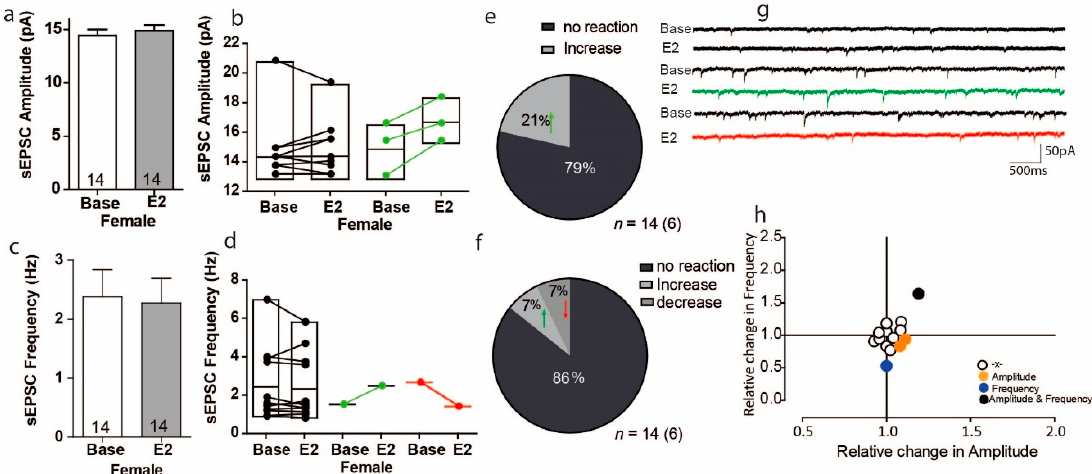
Figure 1. Estradiol causes a reaction in a subpopulation of cells in the PFC of female mice. ( a ) Average amplitude of sEPSC recordings in mPFC during baseline and after E2 treatment. ( b ) Plots showing individual sEPSC amplitude responses to E2 during the baseline and after E2 treatment in the same cell. 3 of 14 cells in the within-cell analyses showed significant increases after E2 treatment. Unless noted, colored symbols represent the subset of cells in which within-cell statistical analyses showed significant effect of E2. Green connected symbol represents cells that had a significant increase in response to E2. ( c ) The overall response to E2 on sEPSC frequency in mPFC during baseline and after E2 treatment. ( d ) Plots showing sEPSC frequency during baseline and after E2 treatment within-cell analyses. Unless noted, red connected symbol represents cells that had a statistically significant decrease in response to E2. ( e , f ) The proportion of cells with a significant response to E2 treatment ( g ). Sample traces, frequencies and amplitudes of sEPSCs before and after E2 treatment ( h ). Plots of the normalized change in sEPSC frequency versus amplitude for each cell; E2 treatment hardly changed the sEPSC frequency and amplitude in the same cell.